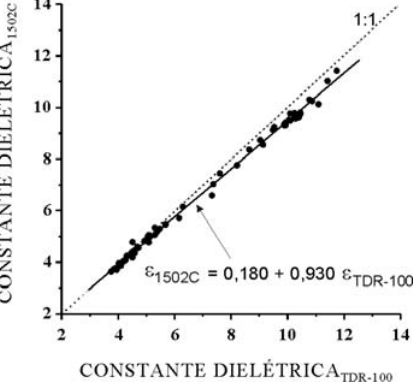
Figura 4. Comparação da constante dielétrica medida com o TDR-100 (Campbell) e o 1502C (Tektronix) para os sete solos estudados, com amostras deformadas, em laboratório.